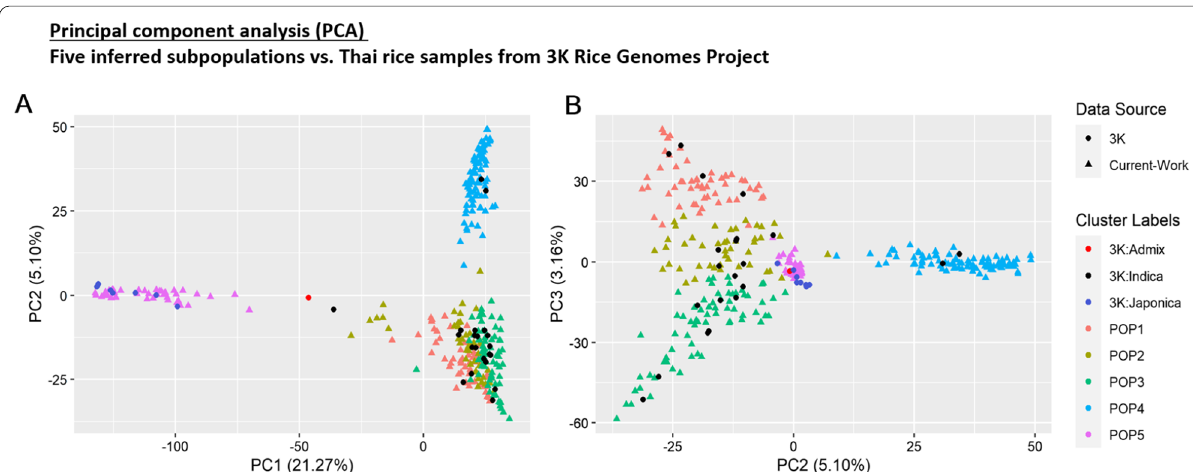
Fig. 3 The Principal component analysis (PCA) for five inferred subpopulations and Thai rice accessions selected from 3K Rice Genomes Project (3K